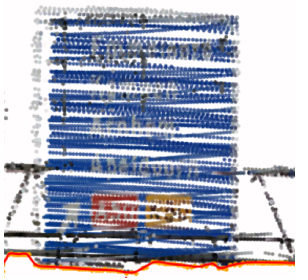
Figure 6. An inaccurately estimated sign bottom edge in